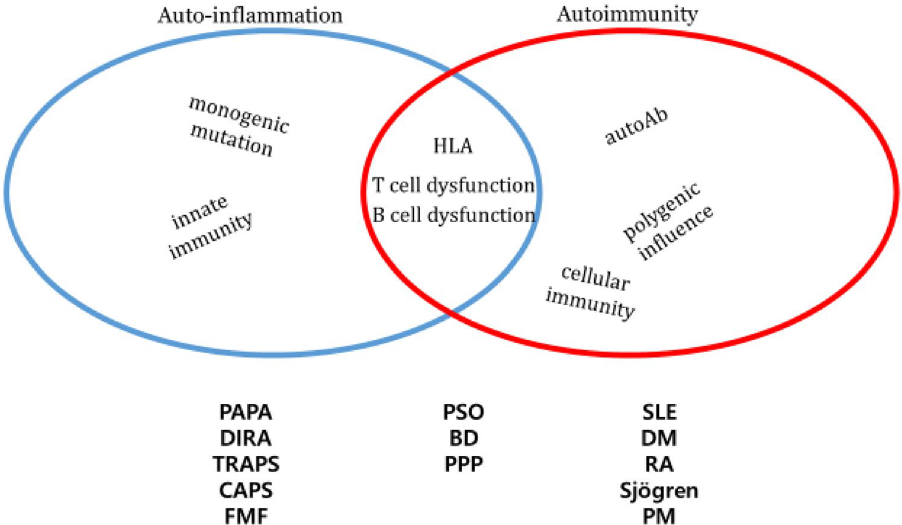
Figure 2. Features of autoinflammation and autoimmunity. HLA, human leukocyte antigen; Ab, antibody; PSO, psoriasis; PPP, pustulosis palmaris et plantaris; BD, Behçet disease; PAPA, pyogenic arthritis, pyoderma gangrenosum and acne syndrome; DIRA, deficiency of the interleukin 1 (IL-1) receptor antagonist; CAPS, cryopyrin-associated autoinflammatory syndromes; FMF, Familial Mediterranean fever; SLE, systemic lupus erythematosus; DM, diabetes mellitus; RA, rheumatoid arthritis; PM,